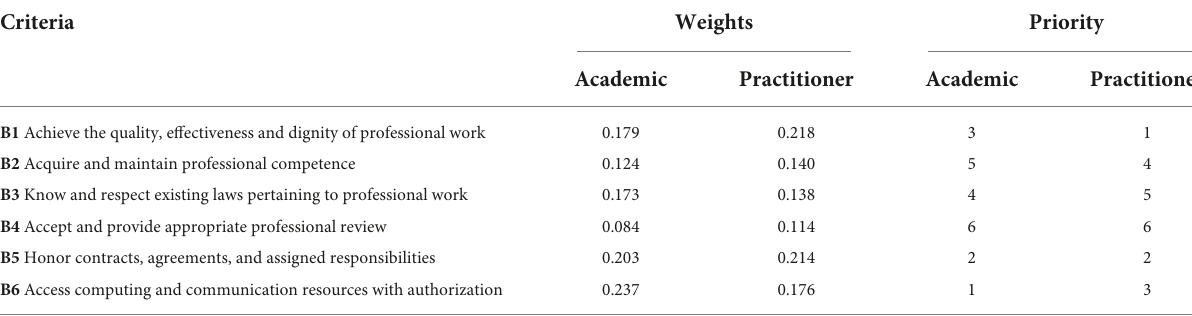
TABLE 8 Weights and ranking of specific professional responsibilities criteria by IT experts.